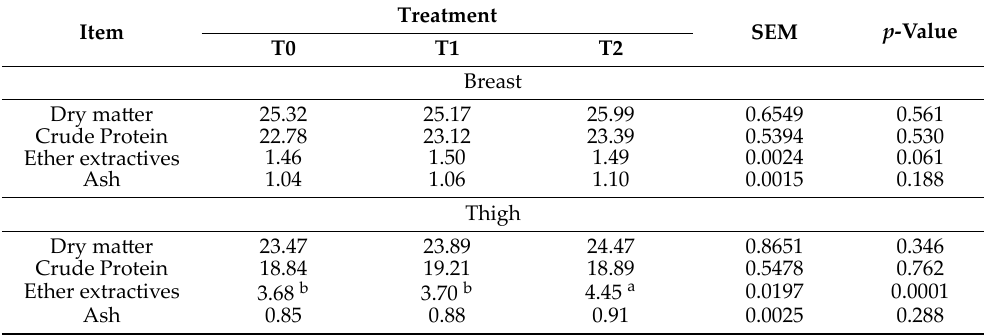
Table 4. Treatment effects on the proximate composition (%) of breast and thigh meat